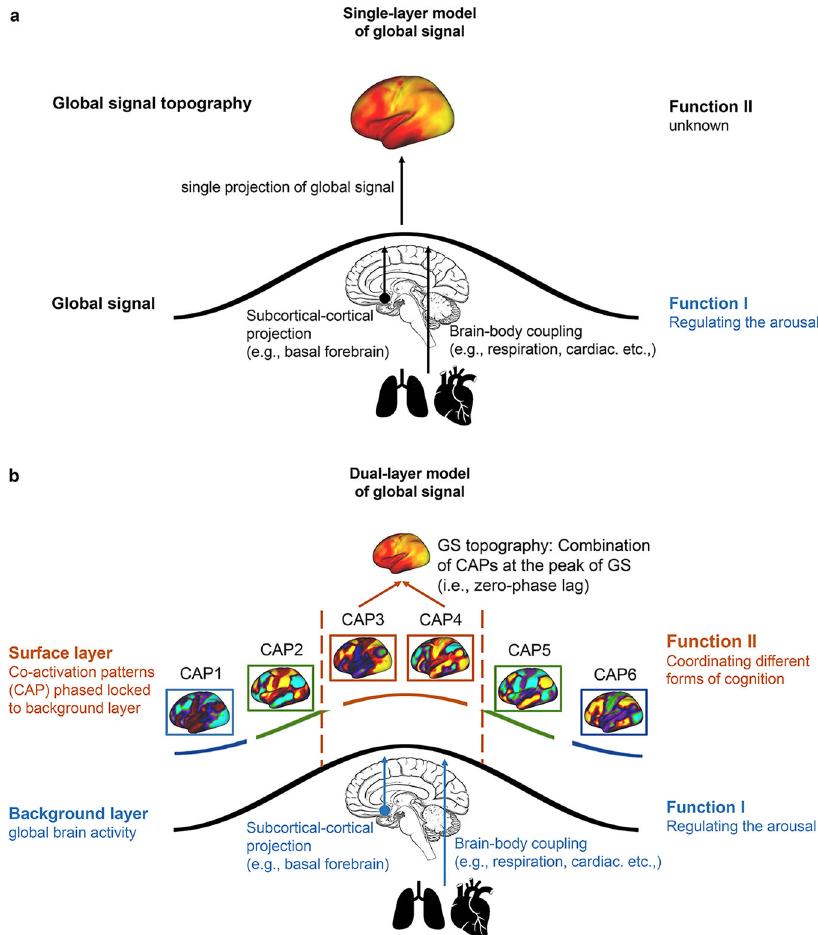
Fig. 4 Single-layer model (SLM) vs. Dual-layer model (DLM) of GS. a The SLM of GS suggests that the GS stems from physiological signal like respiration and cardiac activity, or subcortical areas like basal forebrain. The cortical topography of GS is a consequence of the representation of these subcortical- cortical sources in the brain. Therefore, cortical GS topography is considered to be a mere manifestation of the subcortical-cortical GS itself with both standing in a one-to-one correspondence. b The DLM of GS suggests that GS is a constellation of neural activities at both a more spatially extended global background layer and a more spatially restricted surface layer featuring co-activation pattern of different networks. The background layer is the global brain activity whose neural signals, through its subcortical-cortical phase-based infraslow fl uctuations, are closely coupled with the fl uctuations of the bodily physiological signals like respiration, cardiac activity, and are projected from subcortical to whole brain cortical regions. That, in turn, allows for (1) regulating the level of arousal, and (2) the structuring of the dynamic topography of the cortical instantaneous brain networks/co-activation patterns (CAPs) at the surface layer as basis for coordinating different forms of cognition. Co-activation patterns CAPs; Global signal